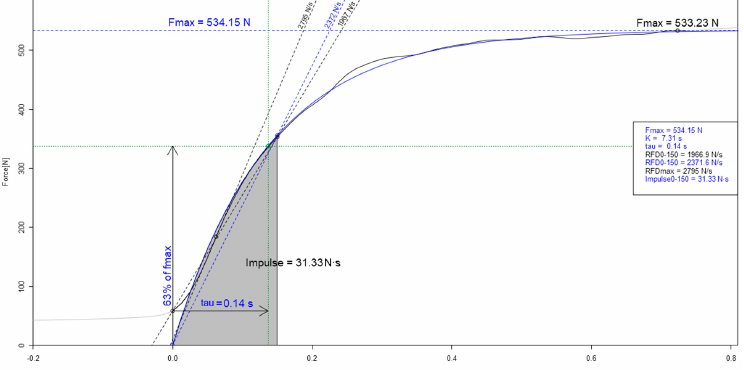
Figure 2. Example (screen-capture obtained from the force sensor software) of some parameters for the force-time curve during the maximal isometric knee extension test. Raw data (original signal) are in black. Fitted data (inverse monoexponentially function that better fits the raw data) are in grey. Note: Fmax is named as maximal voluntary concentric force (MVC) in the present manuscript.